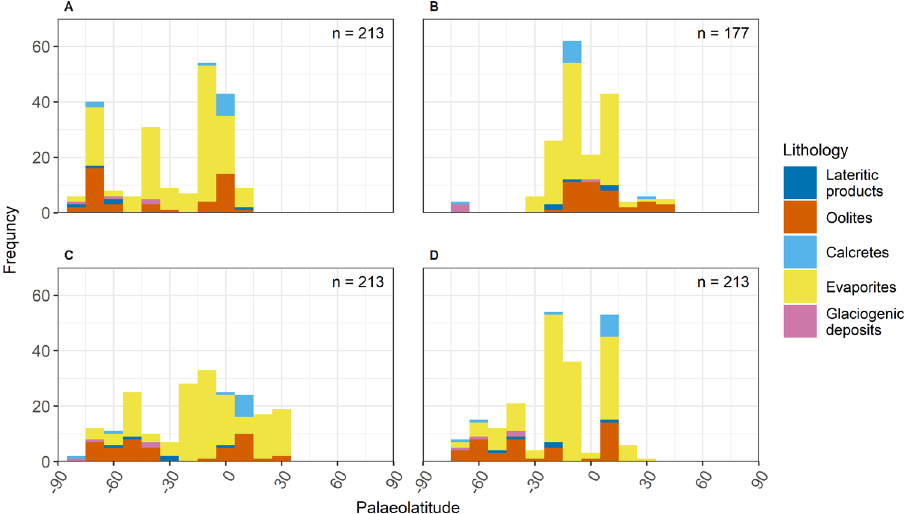
Fig. 3 Zonal distribution of lower Cambrian climatically sensitive lithologies for each continental con fi guration (A – D). Bin width = 10° latitude. See the Supplementary Information for 5° latitude bin width and breakdown by palaeocontinent. The sample size for con fi guration B is smaller due to the absence of North China in this con fi guration 18,19 .